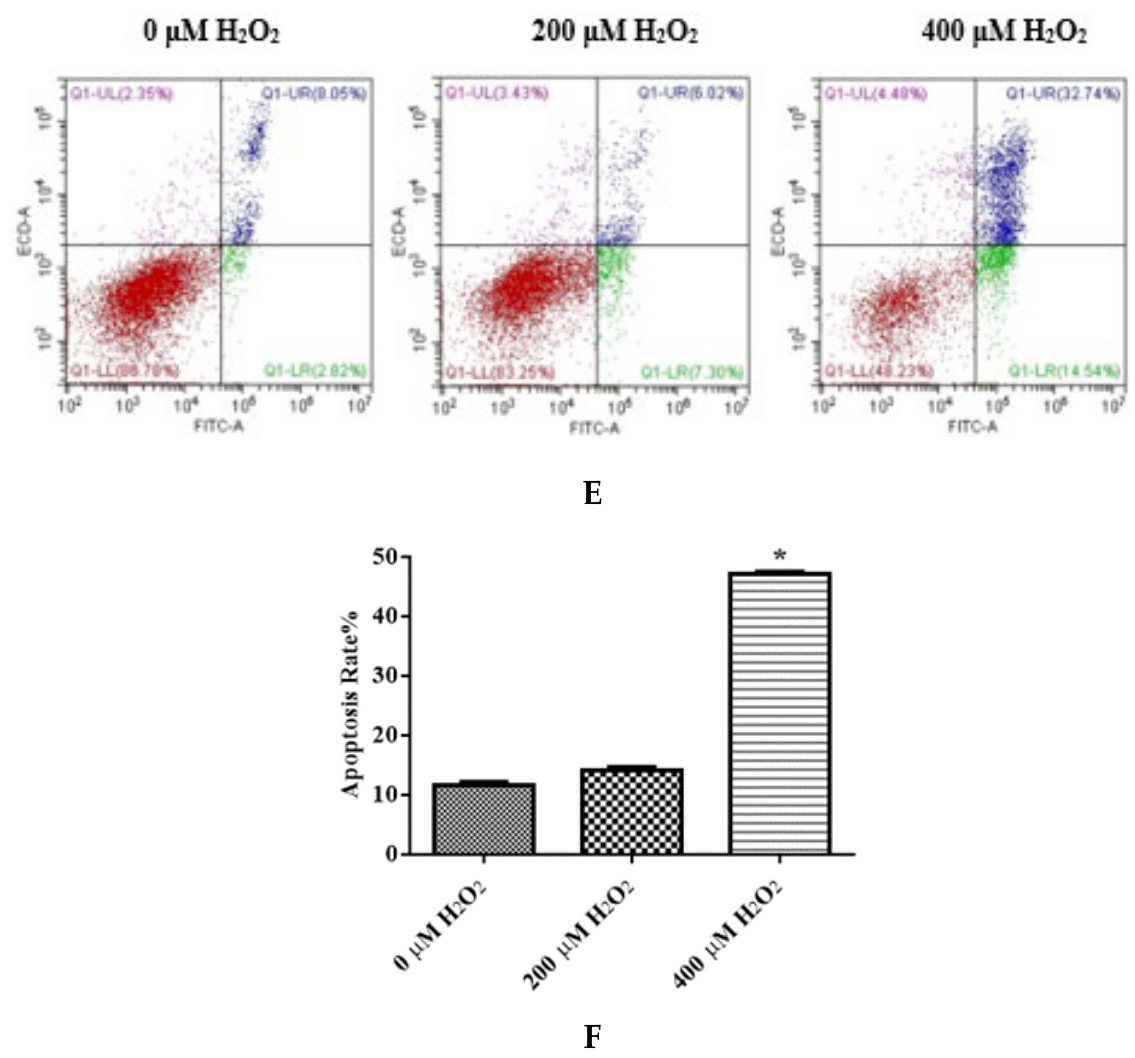
Figure 4. The IDECs were treated with 0 µ M H 2 O 2 , 200 µ M H 2 O 2 and 400 µ M H 2 O 2 for 6 h. ( A ) The ROS production in IDECs treated with different strategies was determined by 2 (cid:48) ,7 (cid:48) -dichlorofluorescein diacetate (DCFH-DA). ( B ) The activities of MDA in IDECs were detected by commercial kits. ( C )